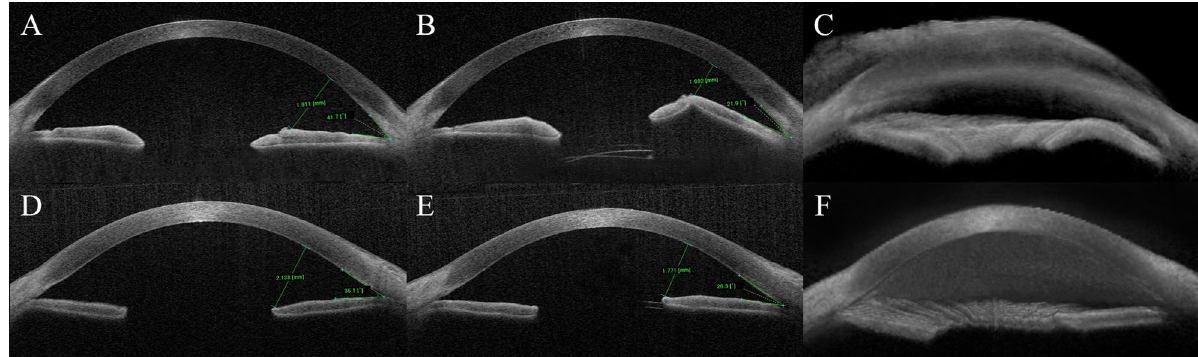
Figure 3. Anterior segment optical coherence tomographic images in two patients with iris tenting after ciliary sulcus Ahmed glaucoma valve implantation. Preoperative ( A , D ), postoperative ( B , E ), and 3D images ( C , F ). In one patient with prominent iris tenting, the iris-cornea angle decreased from 41.7° to 21.9° and the iris-cornea distance decreased from 1.91 mm to 1.09 mm ( A – C ). In the other patient with mild iris tenting, the iris-cornea angle decreased from 35.1° to 26.3° and the iris-cornea distance decreased from 2.14 mm to 1.77 mm ( D – F